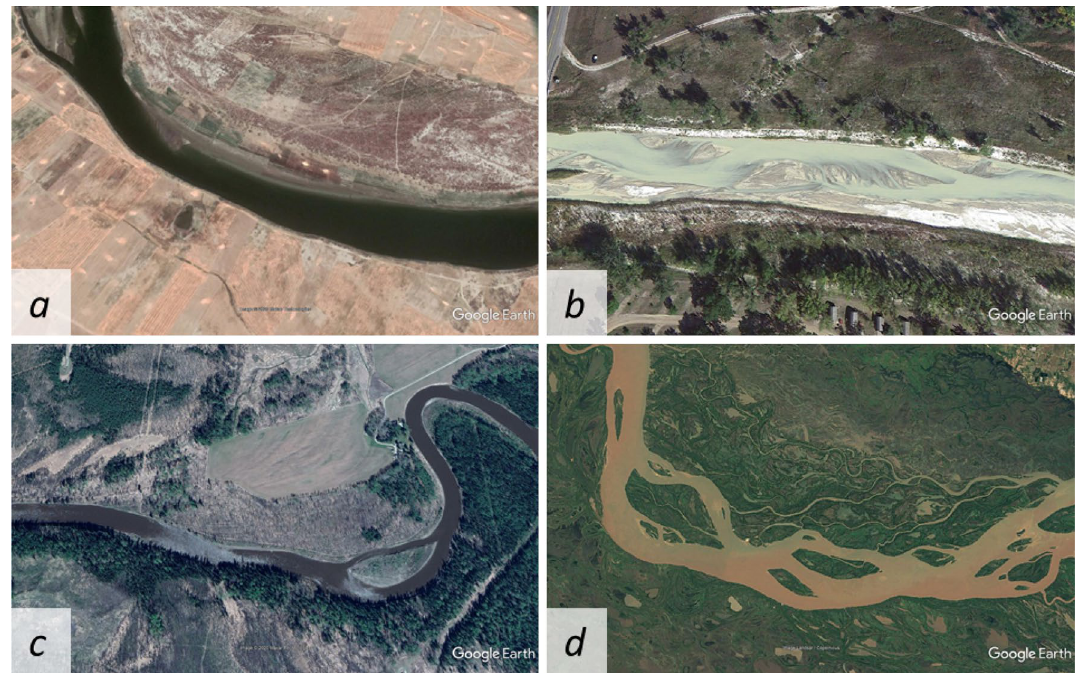
Figure 7. ( a ) Ramganga River, in Uttar Pradesh state, India—Class I (Maps Data: Google, © 2022 Maxar Technologies) ( b ) White River at Interior, South Dakota, USA—Class II (Maps Data: Google, © 2022) ( c ) Pembina River near Paddy Creek, Alberta, Canada—Class III (Maps Data: Google, © 2022 Maxar Technologies) ( d ) Rio Parana, Argentina—Class IV (Maps Data: Google, © 2022 Image